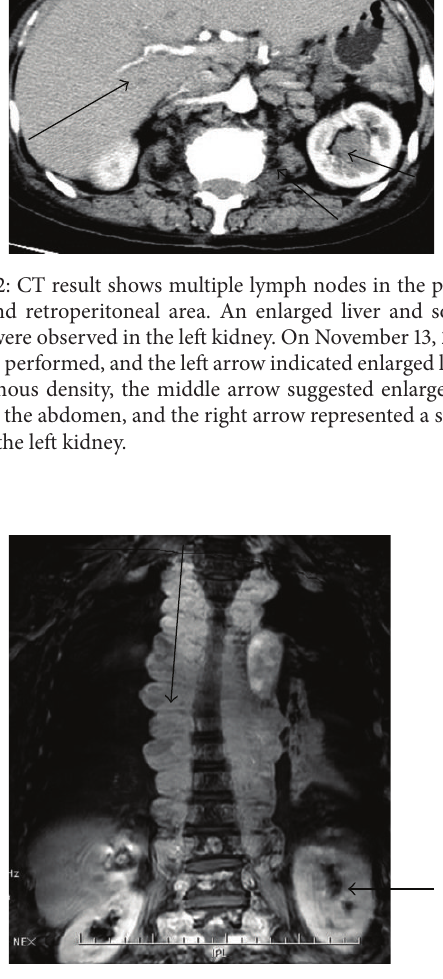
Figure 3: MRI shows asymmetrical soft tissue mass with a stringy appearance surrounding the thoracic vertebral bodies. On Novem- ber 15, 2009, an MRI was performed. The upper arrow indicated soft tissue masses with a stringy appearance surrounding the thoracic vertebral bodies, and the lower arrow suggested a soft tissue mass in the left